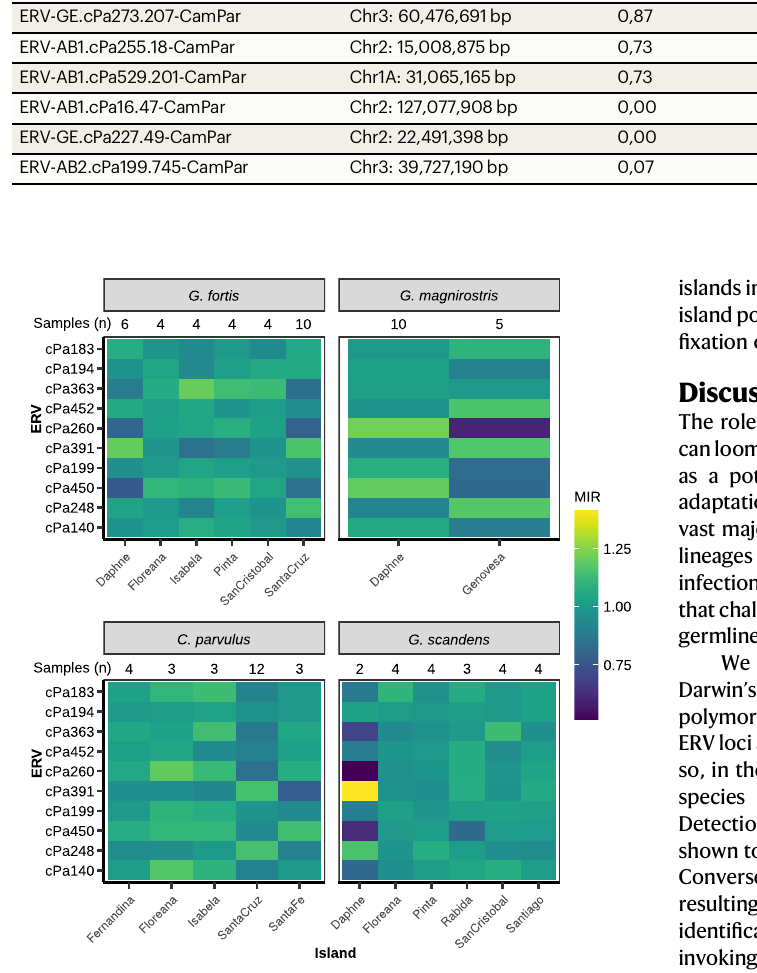
Fig. 5 | Contrasting ERV landscapes across fi nches and islands. Relative abun- dance of the 10 most frequent ERVs showed variation between island populations of the same species. Modi fi ed MIR normalized ERV abundance values both verti- cally across ERVs and horizontally across islands. A contrasting color between island populations for a given ERV indicates a difference in relative abundance between populations, either higher (lighter color), or lower (darker color). Varia- tioninMIRincreasedwithsmallsamplesize(e.g., G.scandens fromDaphneisland),